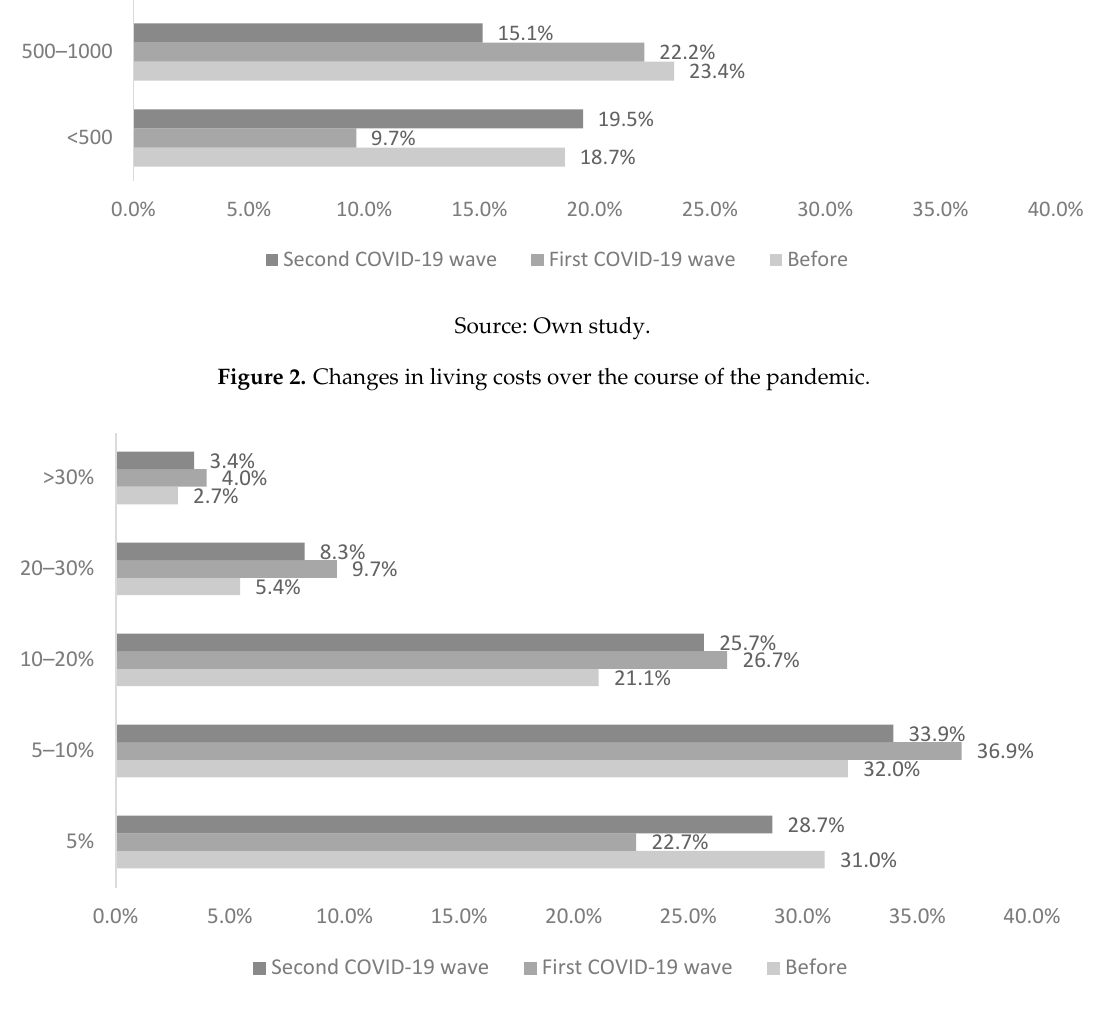
Source: Own study. Figure 3. Changes in energy costs as share of monthly total expenses over the course of the pandemic.